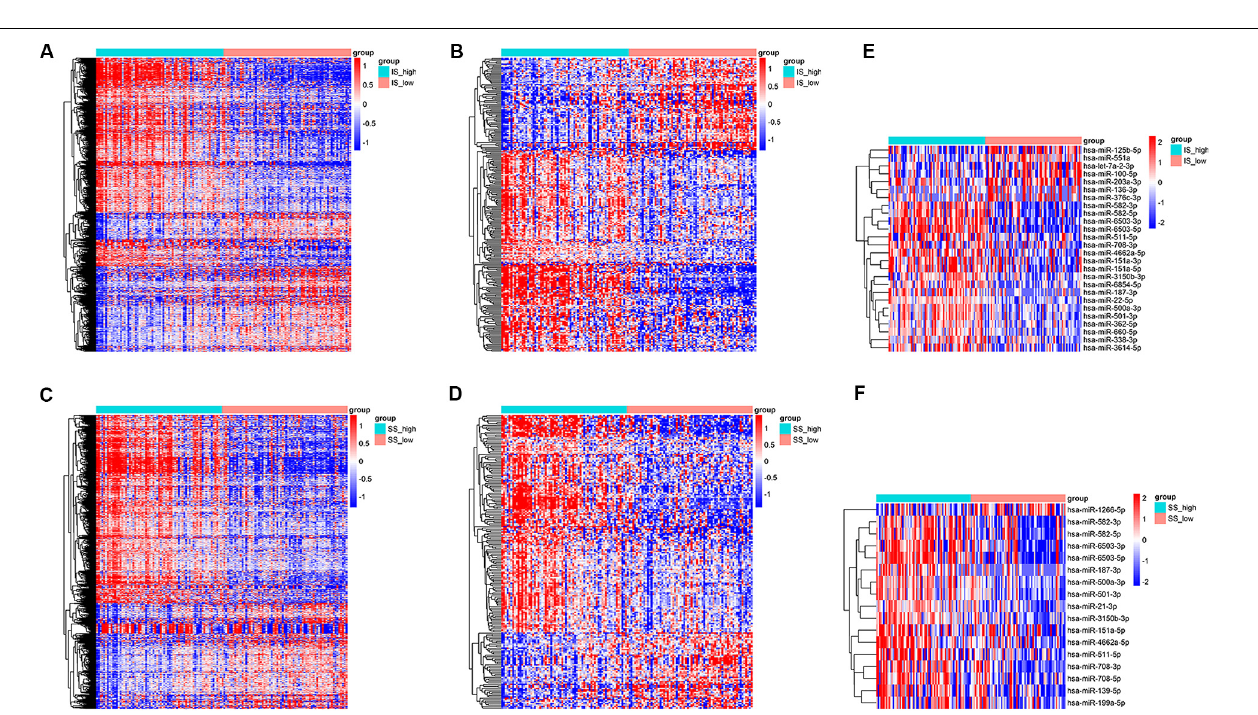
FIGURE 2 | Heatmap of differentially expressed genes in the high and low immune/stromal score groups. (A) mRNAs, (B) lncRNAs and (E) miRNAs based on immune scores. (C) mRNAs, (D) lncRNAs, and (F) miRNAs based on stromal scores.